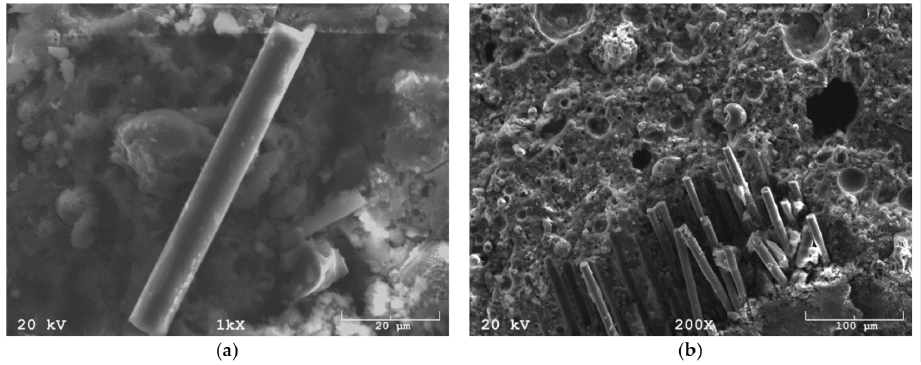
Figure 3. SEM image: ( a ) glass fiber in a geopolymer matrix, ( b ) fibers agglomeration.